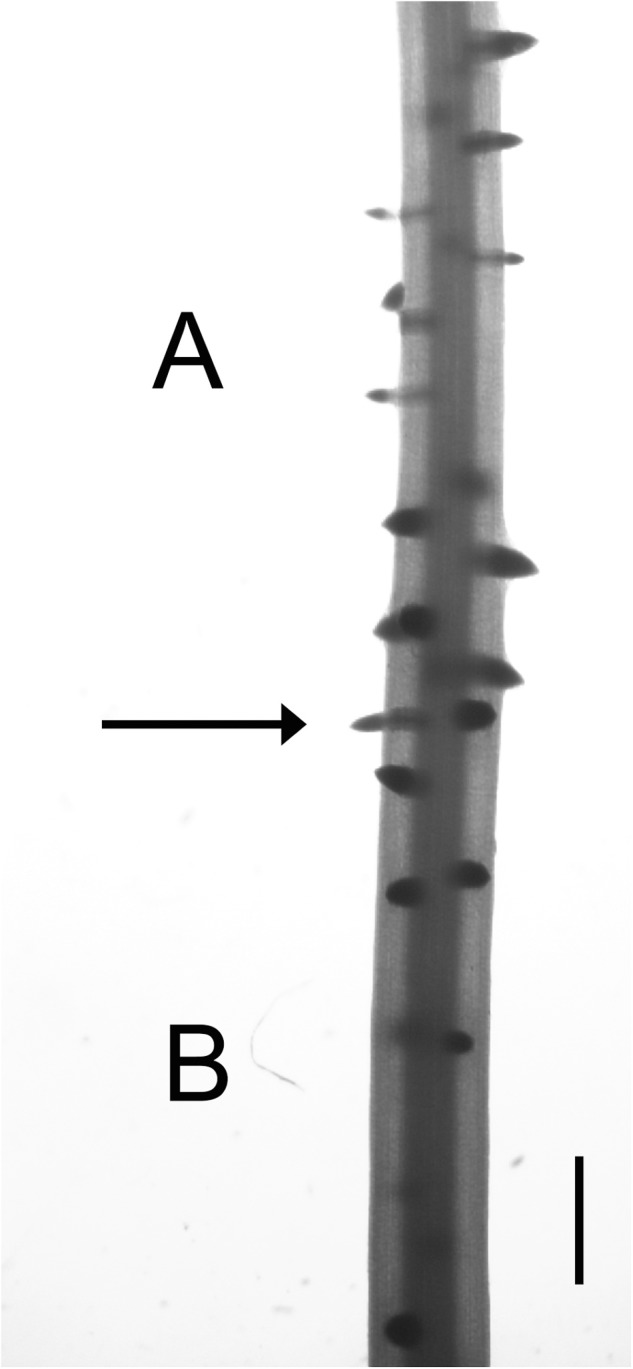
The junction between zones A and B in 0.1 μM NAA-treated maize roots. Micrograph of a maize root fragment at the junction between zones A and B (arrow). Note that zone A zone is thinner and shows a high LRD with numerous emerged lateral roots (LRs). In contrast, zone B is thicker, with relatively few un-emerged LRs. Scale bar = 1 mm.